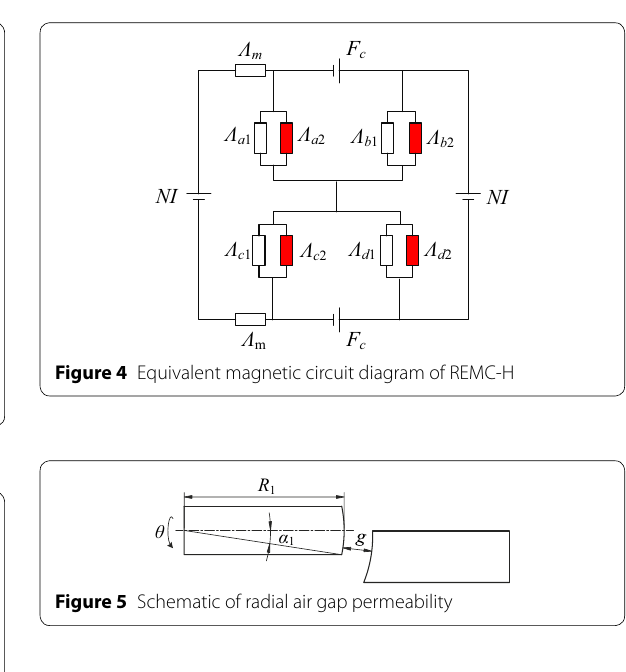
Figure 5 Schematic of radial air gap permeability